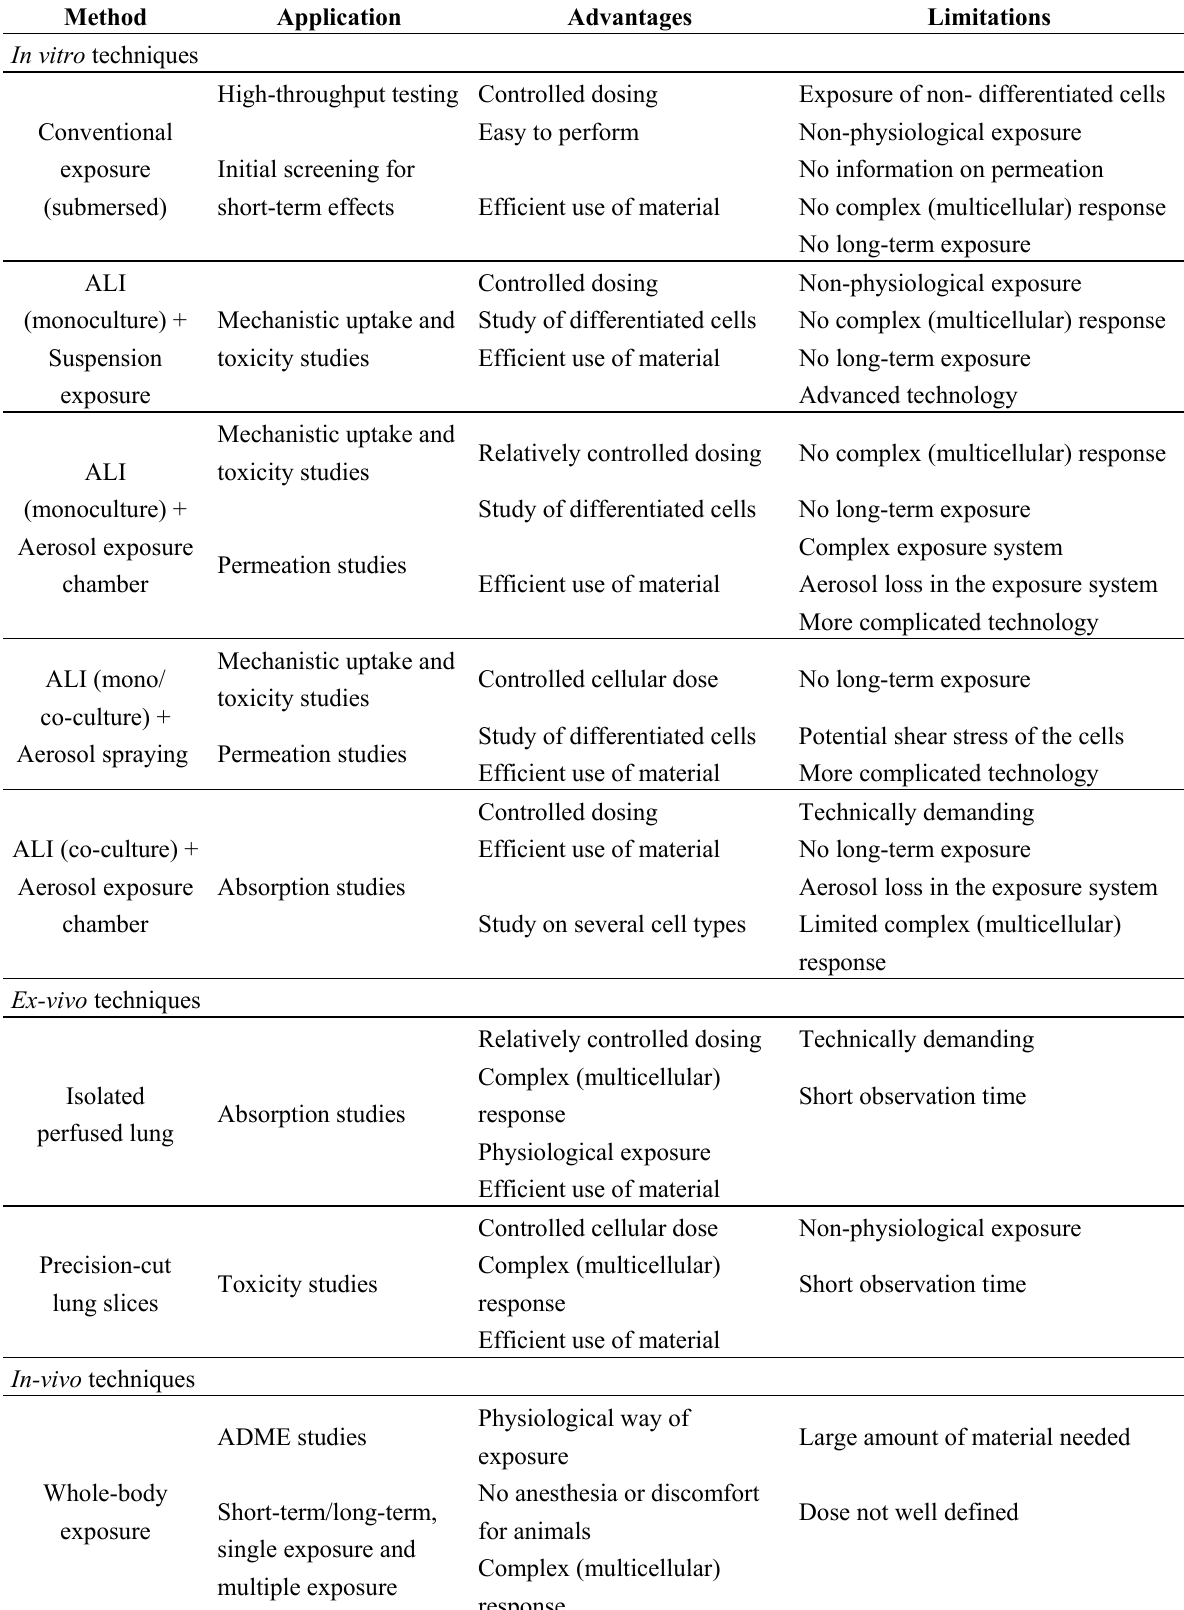
Table 1. Overview of advantages and disadvantages of in vitro , ex vivo , and in vivo studies.